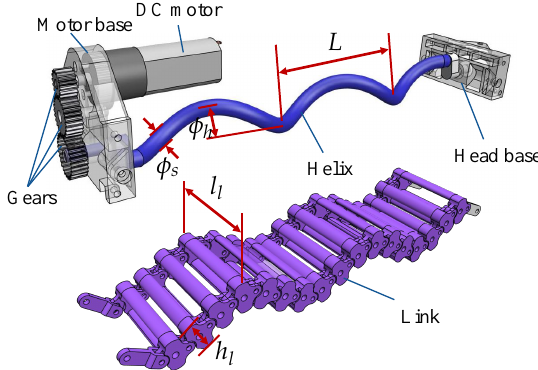
Figure 2. The wave-like crawling mechanism.